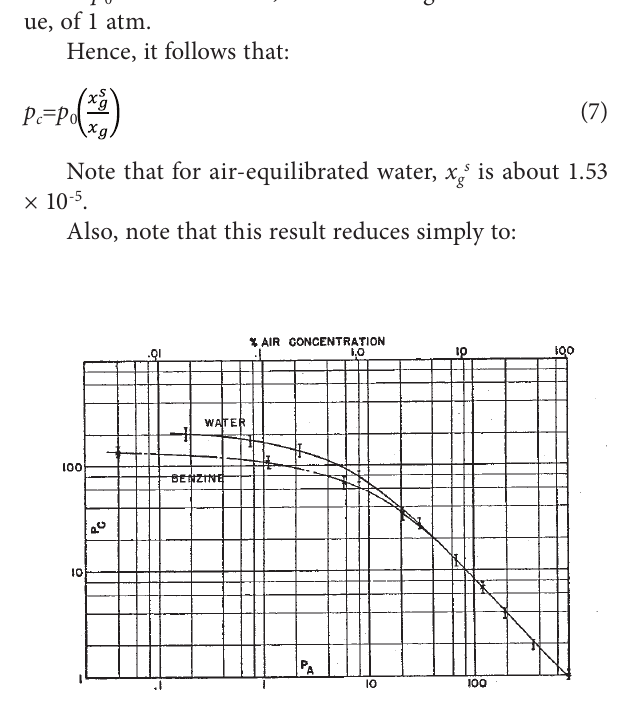
Figure 3 . Experimental data showing the eff ect of de-gassed levels on the suction pressures required to produce cavitation in water and benzene. Reprinted with permission from Ref 16. Copyright 1954, Acoustic Society of